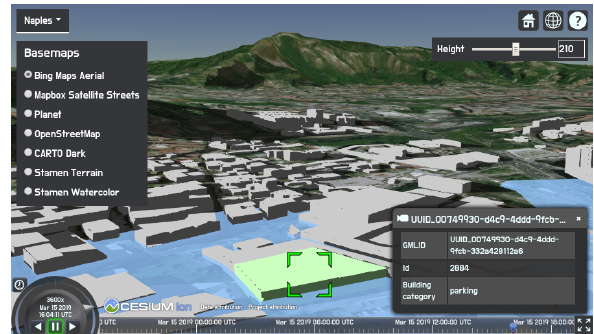
Figure 3. Flood simulation in Naples with 3D buildings visualization and query